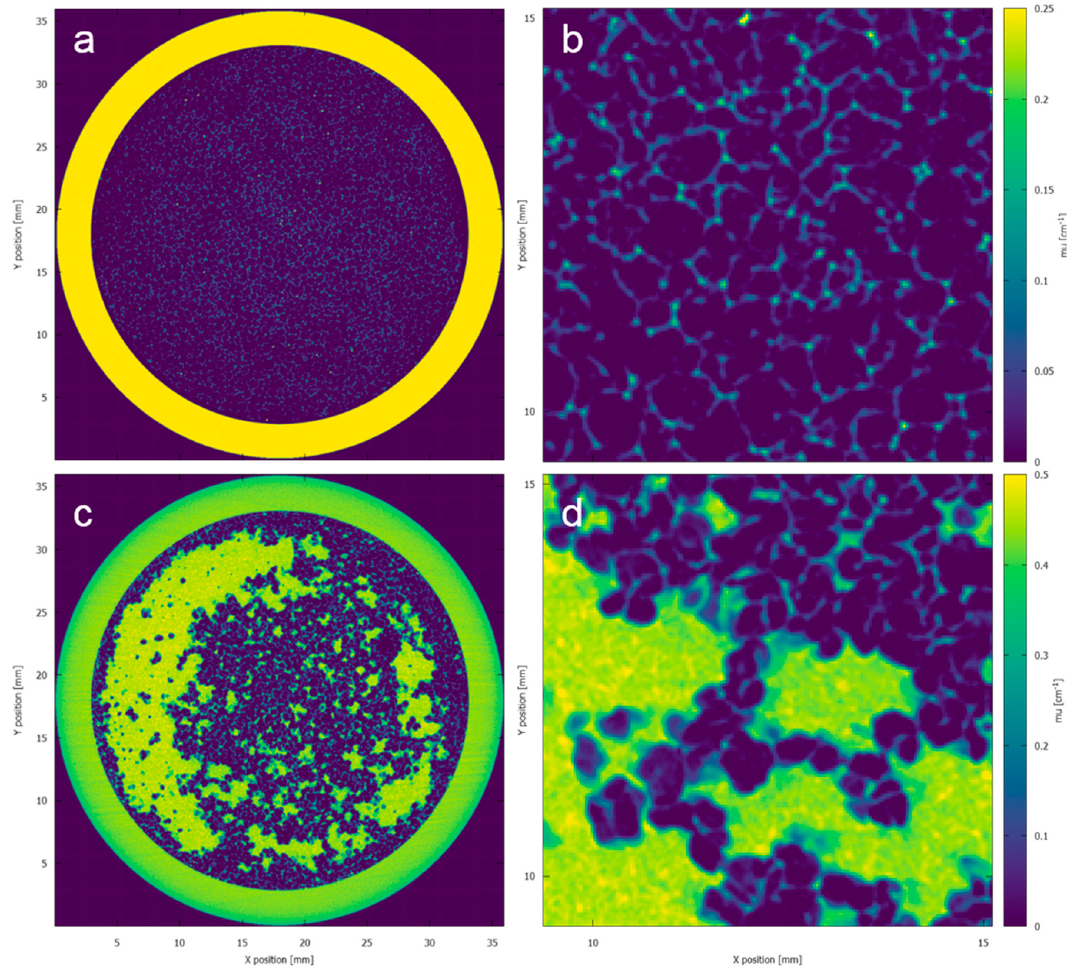
Figure 3. ( a ) Cross sectional image indicating the microstructure of the dry sponge. ( c ) Cross sectional image of sponge with water and olive oil without application of contrast agent. ( b , d ) Zoomed images of the result shown in ( a , c ), depicting the microstructure of the sponge and water and non-contrasted olive oil in the sponge, respectively. The colormap illustrates the reconstructed attenuation coefficient of different materials.